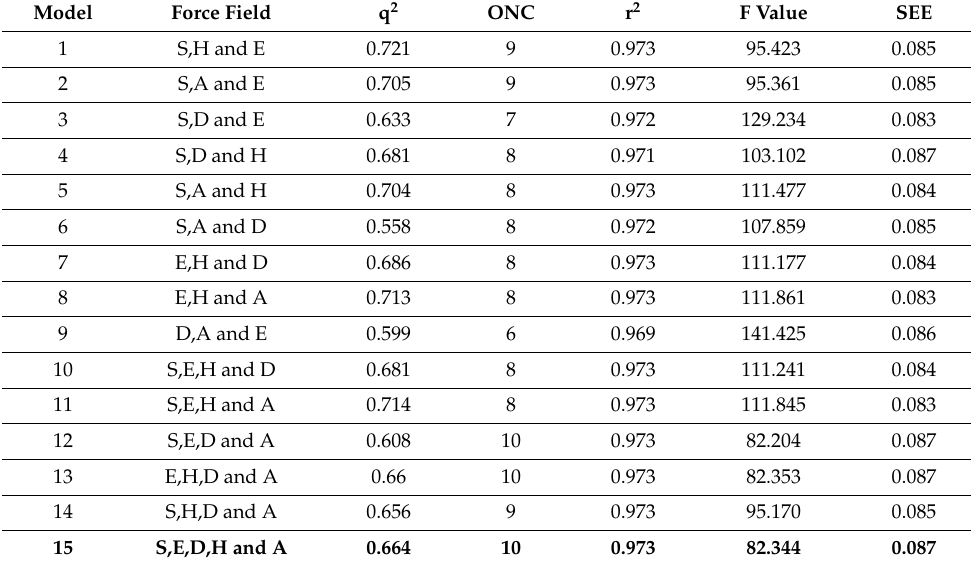
Table 2. The parameters of the CoMSIA model and the statistical parameters of the best model (shown in bold).